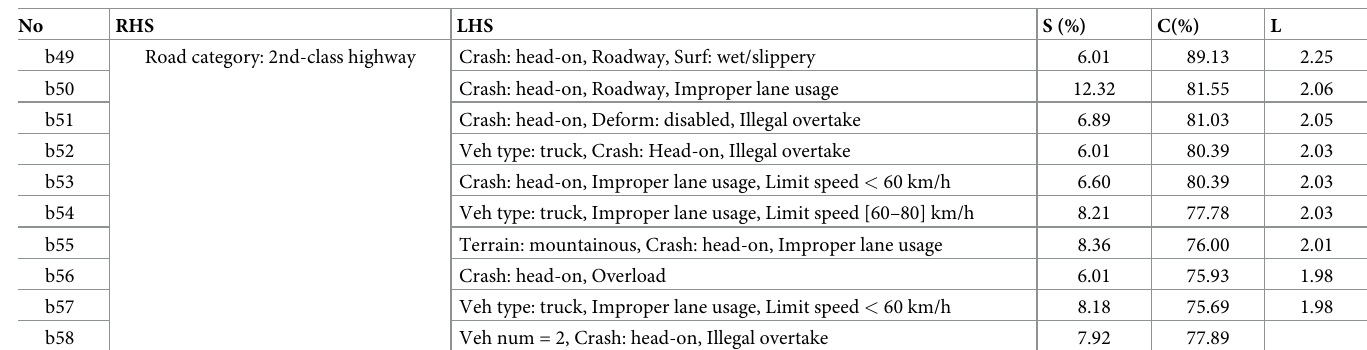
downhill curve section is as high as 95.74, which is 2.71 times the average proportion.